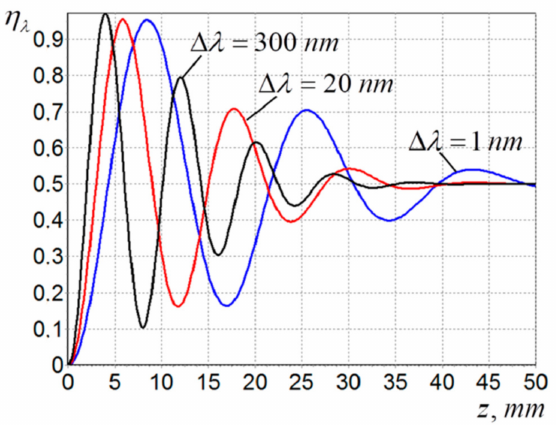
Figure 11. Energy efficiency dependence in quasi-monochromatic Bessel–Gauss beams in a lithium niobate crystal.